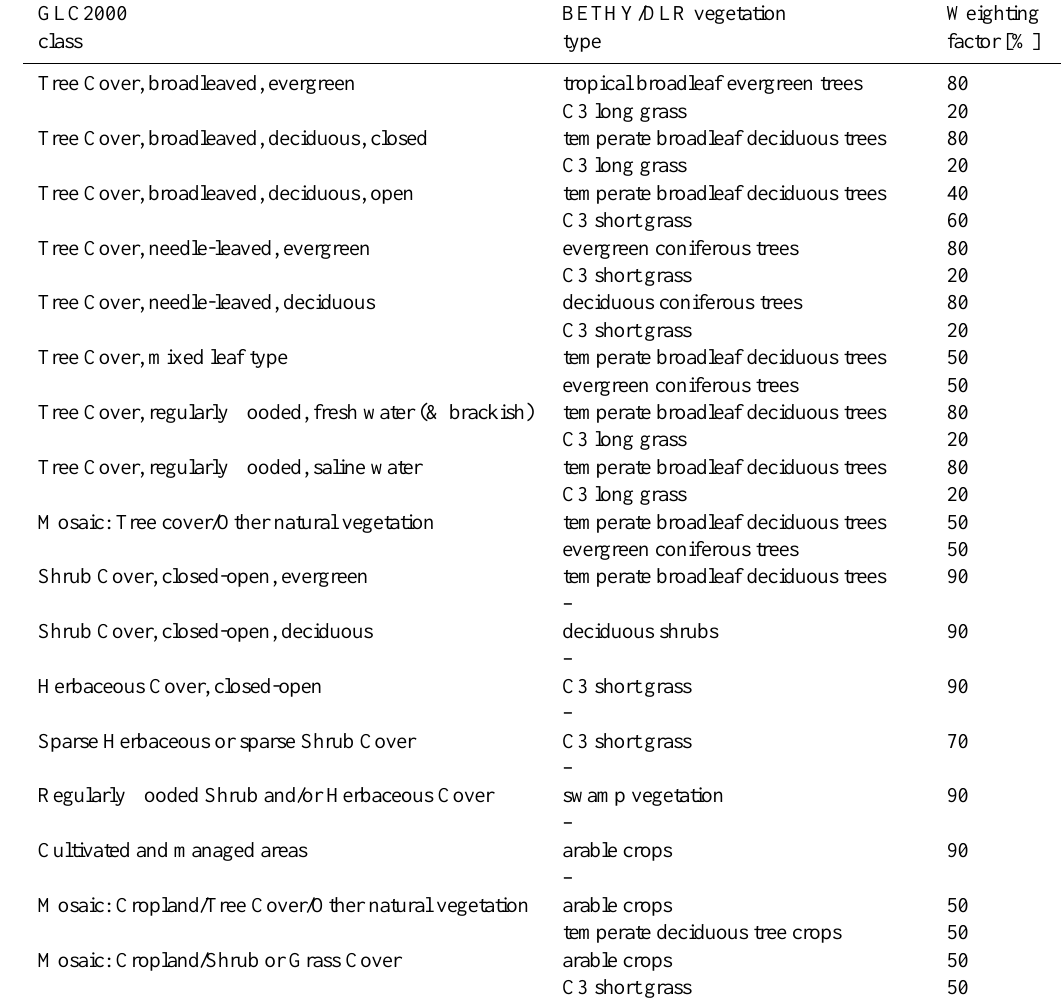
Table 1. Translation of GLC2000 vegetation classes to BETHY/DLR vegetation types with weighting factors. GLC2000